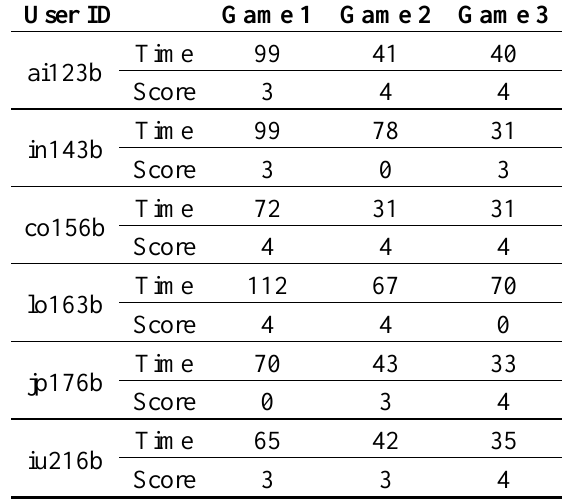
Table 4. Results obtained by participants in evaluation of the